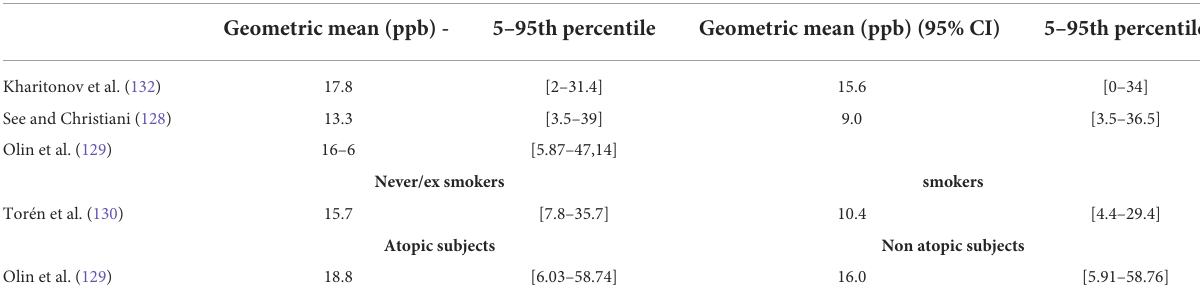
TABLE 6 Reference values of FENO in healthy